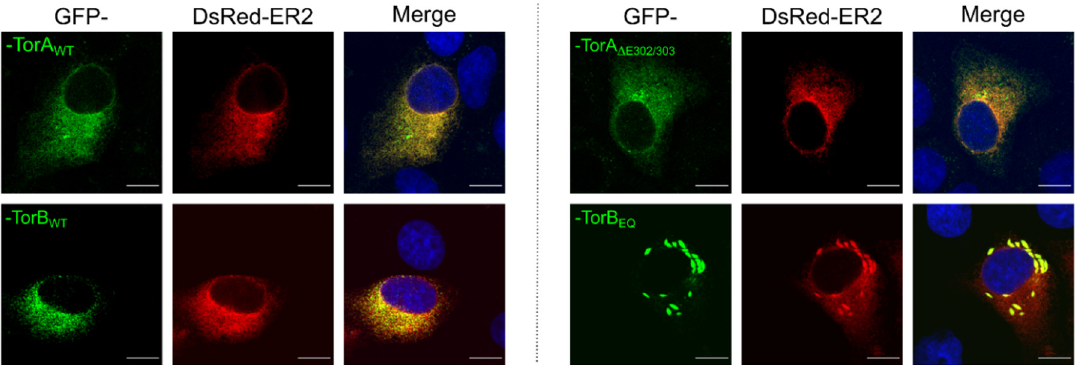
Figure 2. Localization of GFP-tagged constructs in RK13 cells. Representative images of RK13 cells transiently expressing the GFP-tagged constructs. Cells were co-transfected with plasmids expressing the DsRed2-ER marker and the GFP-tagged Torsins. Nuclei were counterstained with DAPI and autofluorescence was detected with a confocal laser scanning microscope. Scale bars indicate 10 µm.